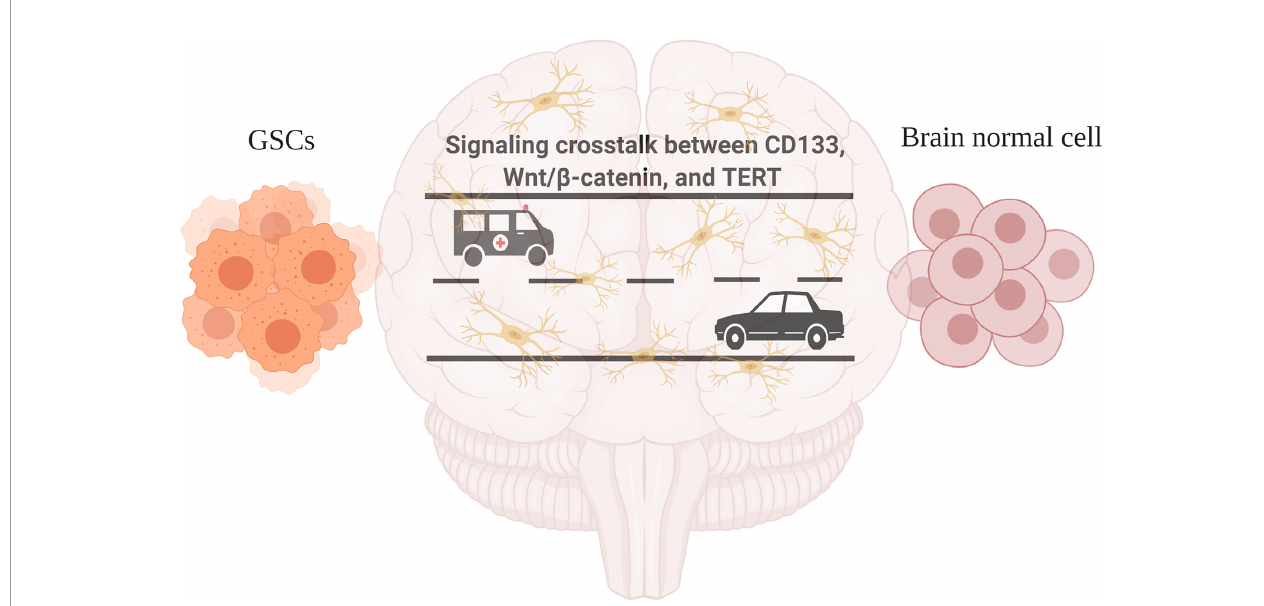
FIGURE 1 | Signaling crosstalk between CD133, Wnt/ b -catenin, and TERT: Rescue and Rancor in brain that is a question. (Created with